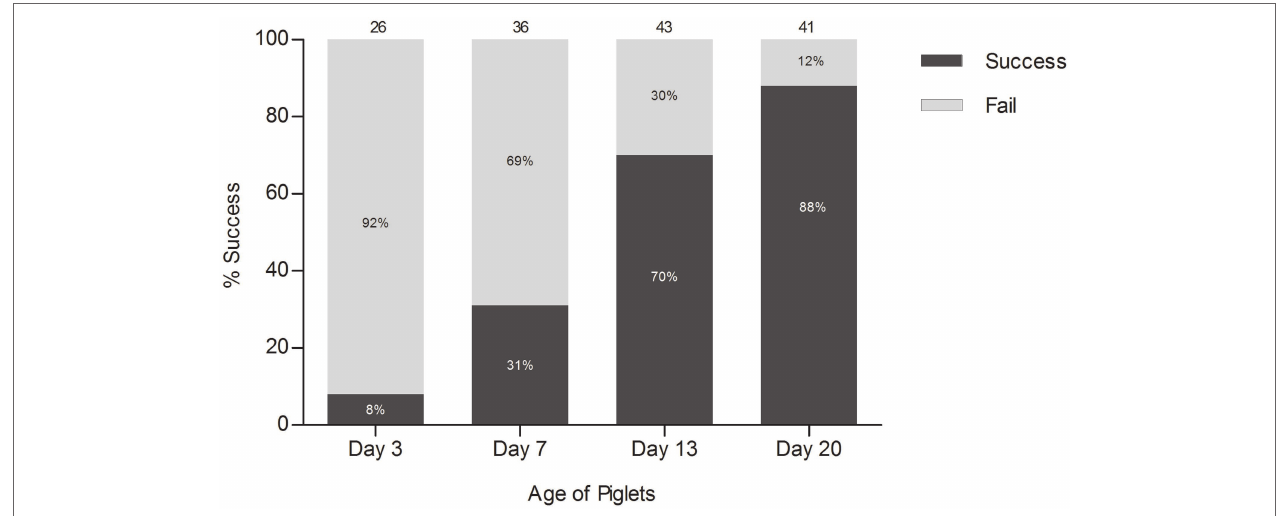
FIGURE 1 | Success rate of rectal stimulation. The numbers at the top of each bar represent the total number of piglets that were stimulated rectally at each